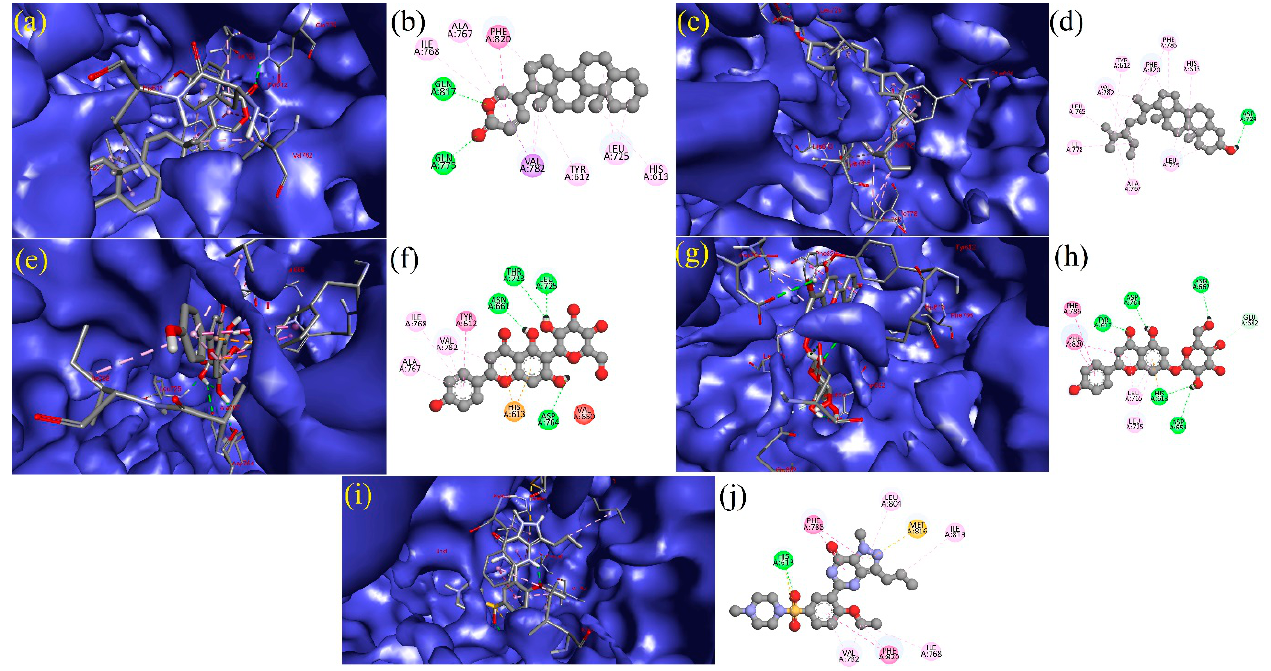
Figure 3. Depicted the interaction between the compound Bufadienolide and PDE5. Left side representing the 3D ( a ) and the right side representing the 2D complex of the PDE5–Bufadienolide interaction ( b ). Depicted the interaction between the compound Stigmasterol and PDE5. Left side representing the 3D ( c ) and the right side representing the 2D complex of the PDE5–Stigmasterol interaction ( d ). Depicted the interaction between the compound Isovitexin and PDE5. Left side representing the 3D ( e ) and the right side representing the 2D complex of the PDE5–Isovitexin interaction ( f ). Depiction of the interaction between the compound Apigetrin and PDE5. Left side representing the 3D ( g ) and the right side representing the 2D complex of the PDE5–Apigetrin interaction ( h ). Depiction of the interaction between the compound sildenafil and PDE5. Left side representing the 3D ( i ) and the right side representing the 2D complex of the PDE5–sildenafil interaction ( j ).